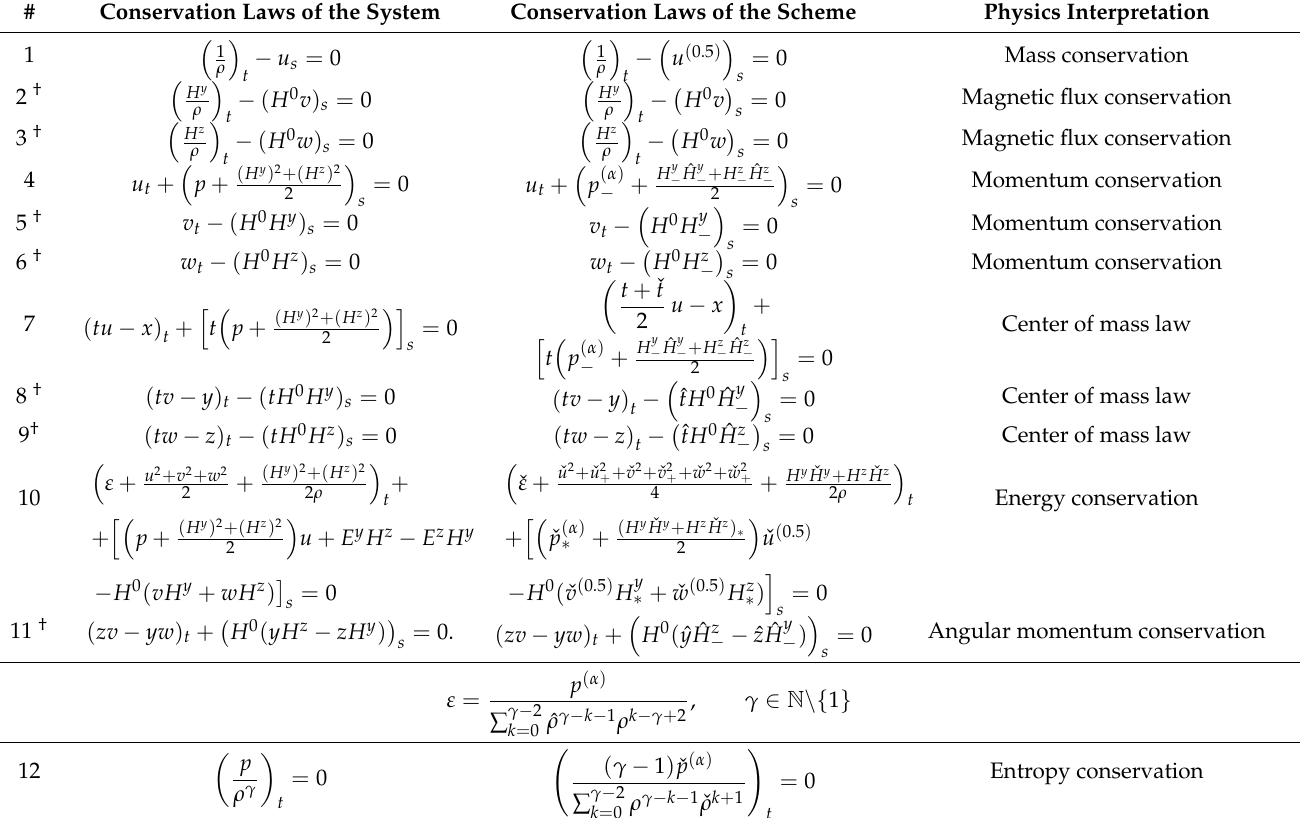
Table 3. Differential and difference conservation laws for the modified scheme (39) (and the corre- sponding system (36) for an arbitrary entropy S ( s ) in case σ → ∞ . Conservation Laws of the